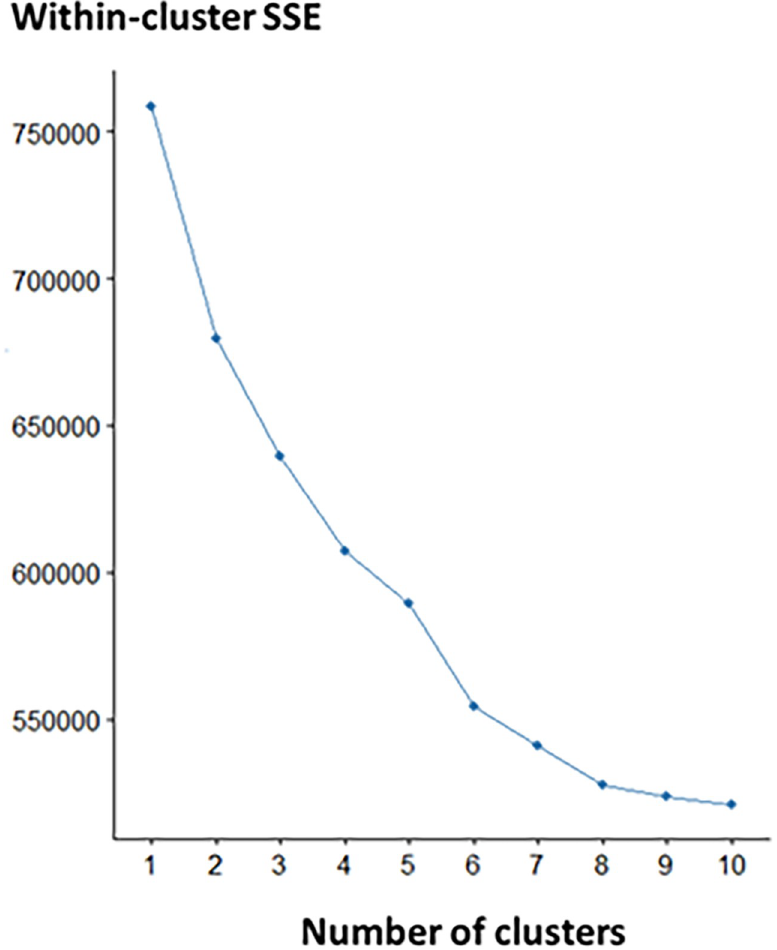
Fig 6. Elbow method. Elbow method shows the relationship between within-cluster SSE and number of clusters. Abbreviation: within-cluster SSE, within-cluster sum of squared errors.